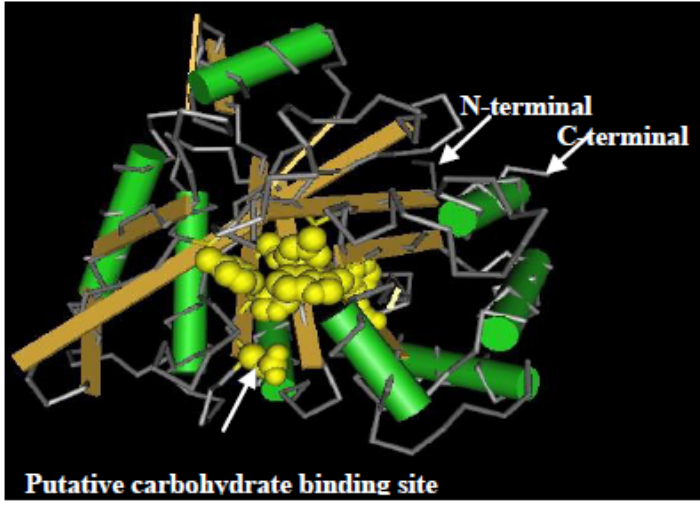
Figure 4. Three-dimensional structural analysis of the GH18_narbonin (cd06544) domain, which was similar to ScChi by Blastp. The presence of putative carbohydrate binding sites, which was highly homologous to ScChi, is shown in the 3D structure of GH18_narbonin by arrows.